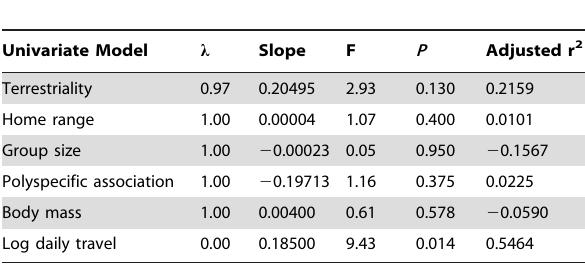
Table 2. Phylogenetic generalized least-squared multiple regression models of the relationship between Oesophagostomum prevalence and univariate life-history variables of diurnal primates (excluding humans) within the Kibale community.